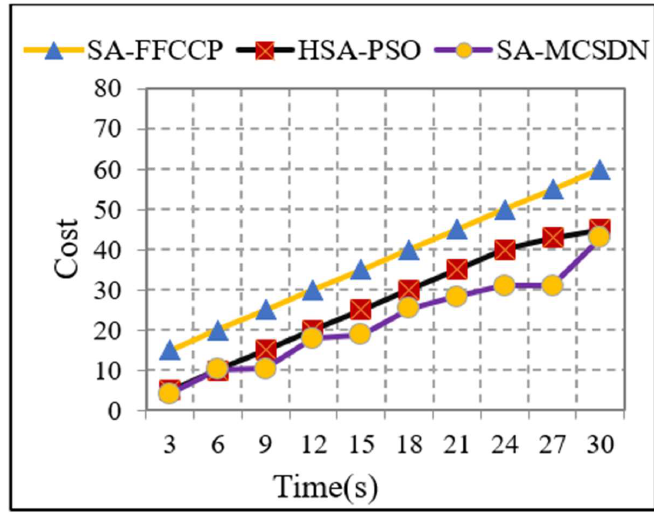
Figure 12. Comparison of cost.